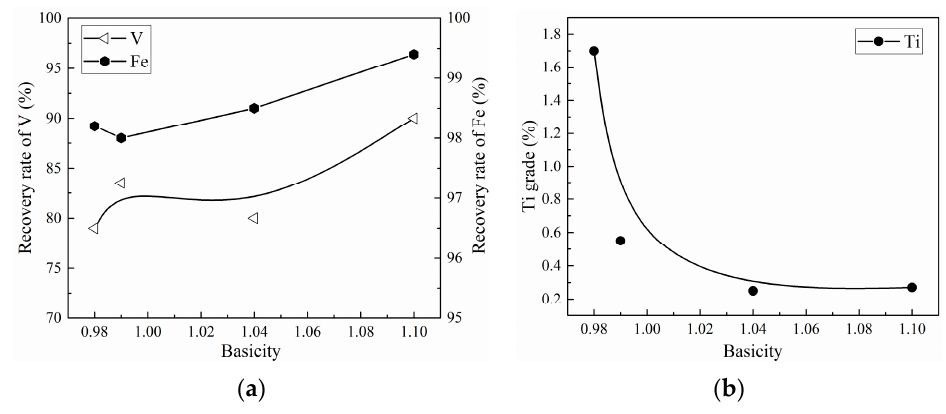
Figure 8. ( a ) Effects of quaternary basicity by addition of CaO on Fe and V recovery rates; and ( b ) effects of quaternary basicity by addition of CaO on Ti grade in iron.